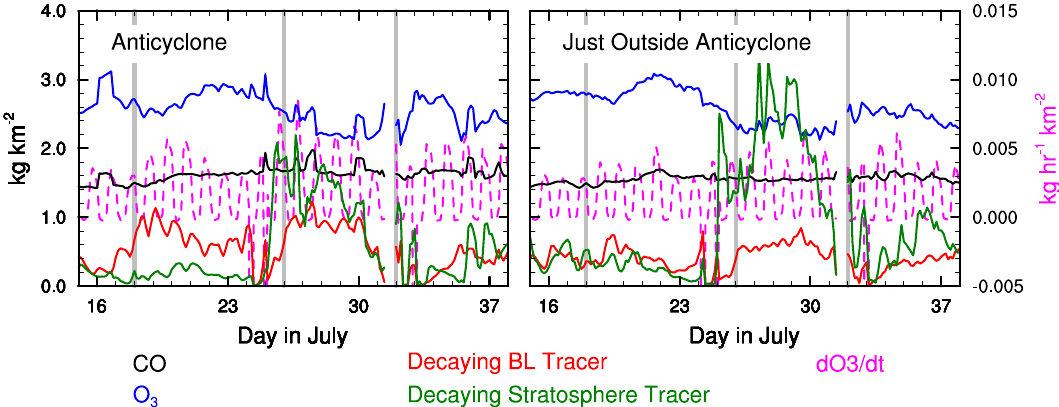
Fig. 13. Mass per unit area of CO (black line), O 3 (blue line), decaying boundary layer tracer (red line), and decaying stratosphere tracer (green line), and chemical ozone tendency (dashed magenta line; right axis) in the upper troposphere (8–12km altitude range) within the Anticyclone and Just Outside the Anticyclone. The horizontal area of the Anticyclone is defined as the region by z > 9730m at 300hPa. The horizontal area of the Just Outside Anticyclone region is defined as the region by 9730m > z > 9680m at 300hPa and only includes grid points within 600km of the Anticyclone. The boundary layer scalar and stratosphere tracer masses per area are the respective masses of air in units of 2 × 10 6 kgkm − 2 and 1 × 10 6 kgkm − 2 , respectively. On the 31 July, geopotential heights were < 9730m, so the Anticyclone could not be